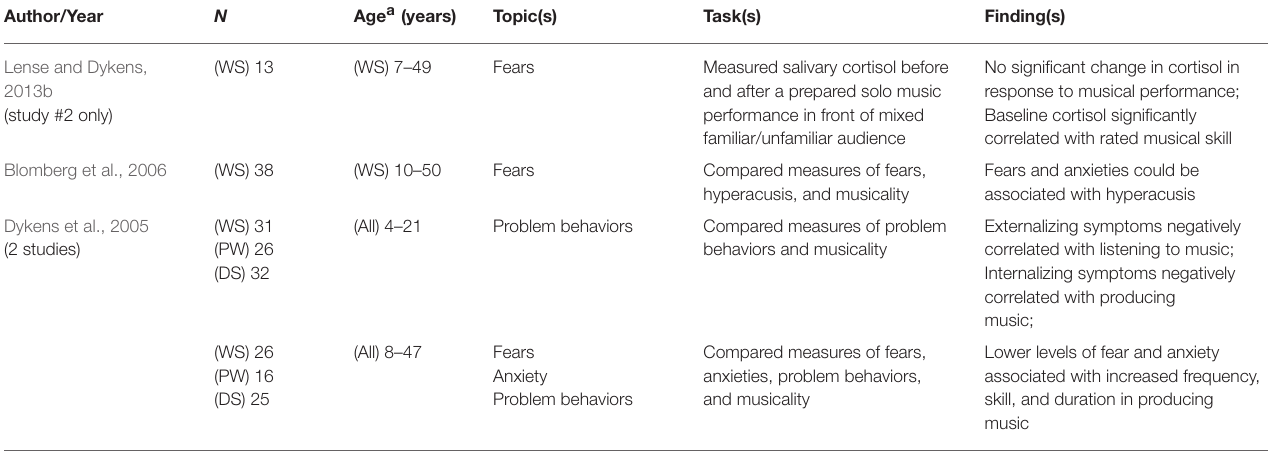
TABLE 8 | Fears, anxieties, and problem